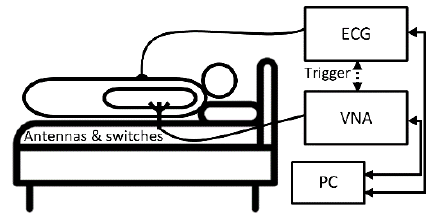
Figure 7. Schematic diagram of the ultra-wideband (UWB) radar proposed in [44].